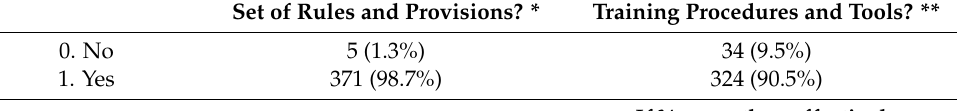
Table 2. OSH rules and provisions, training procedures and tools: level of enforcement and utilization. Do You Have in Your Country a Are There in Your Country Set of Rules and Provisions? * Training Procedures and Tools? **